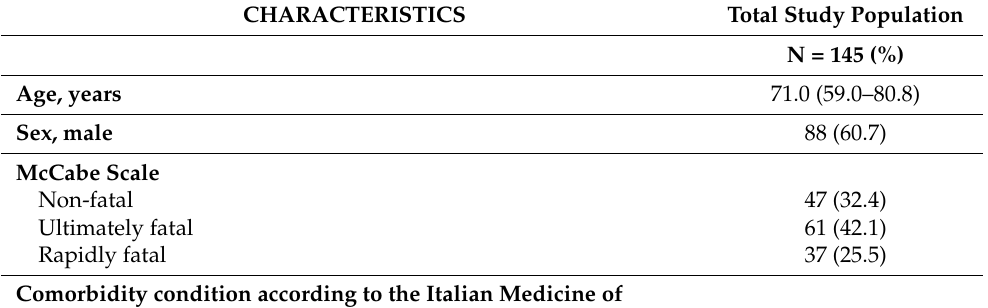
Table 1. Baseline characteristics of 145 coronavirus disease 2019 (COVID-19) patients treated with